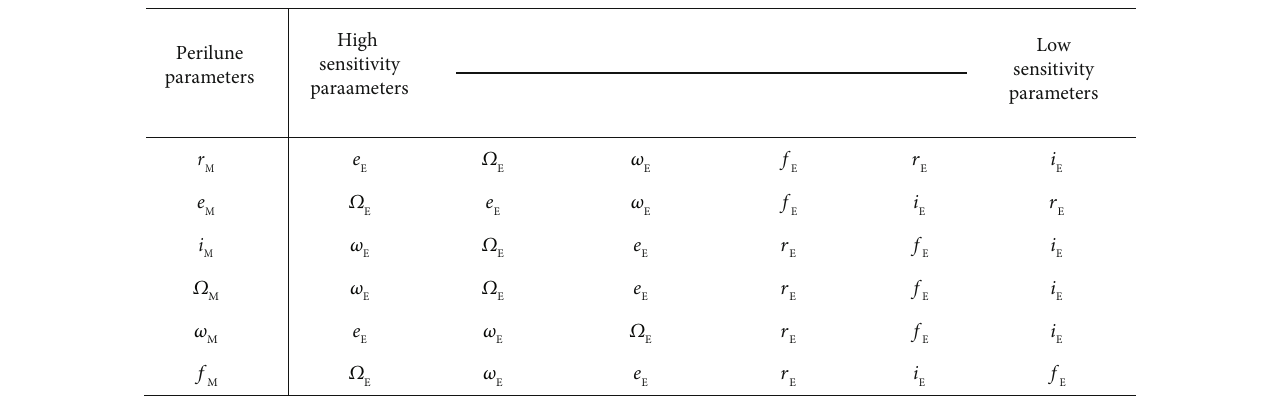
Table 11: Sorting of parametric sensitivity analysis results. Perilune